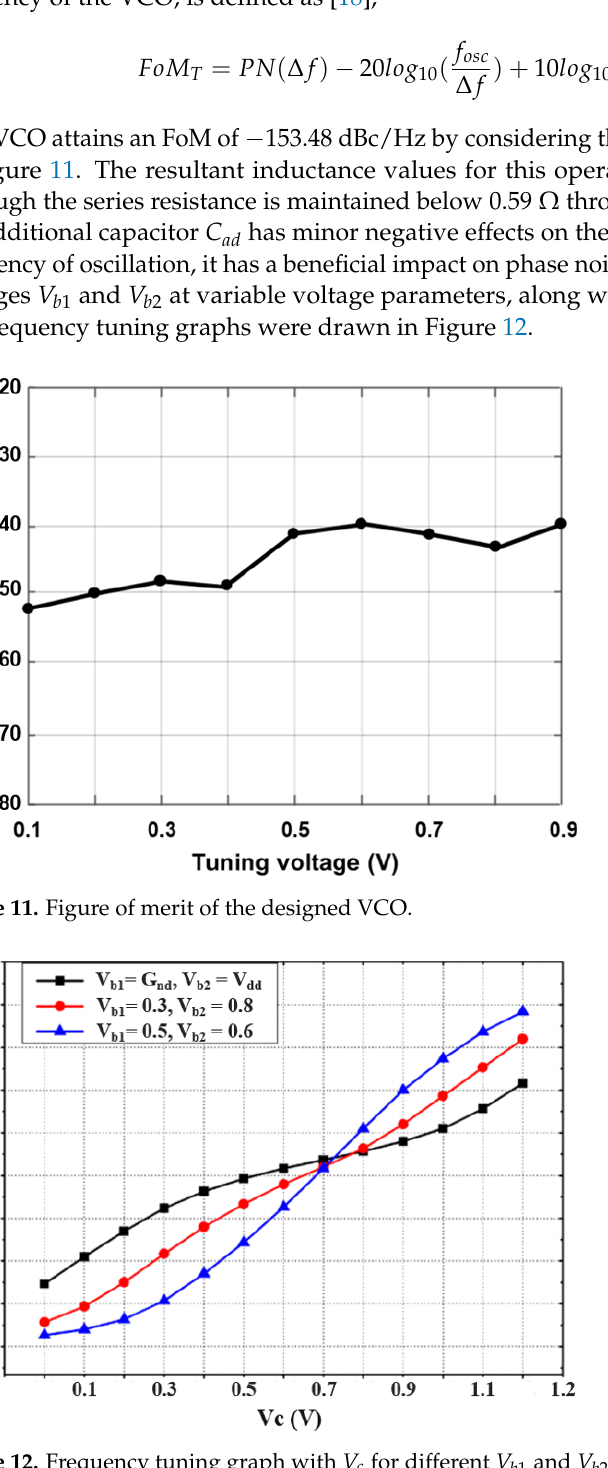
Figure 12. Frequency tuning graph with V c for different V b 1 and V b 2